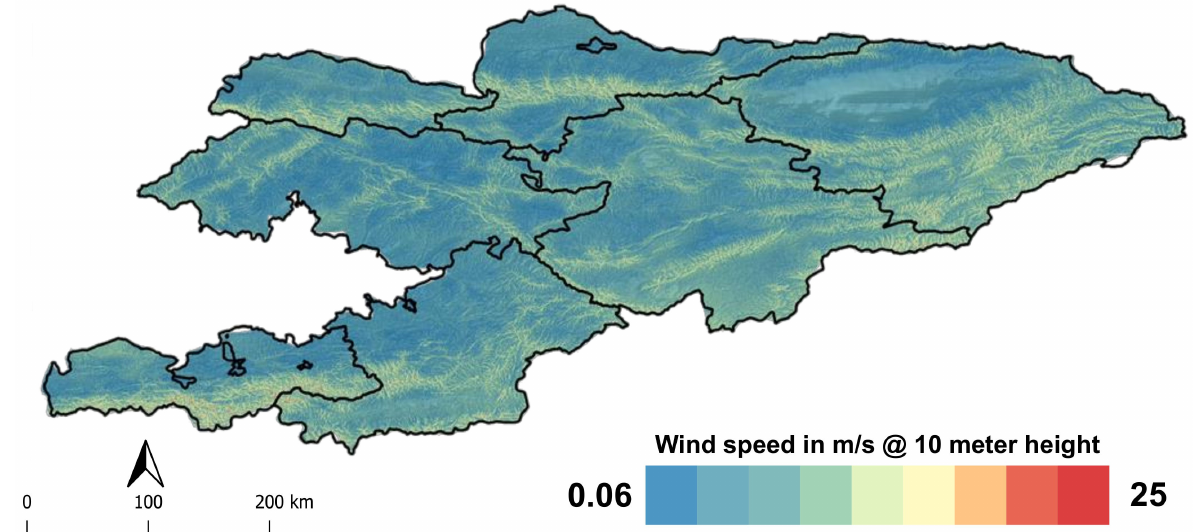
Figure 3. Wind speed atlas of Kyrgyzstan at 10 m in height (own illustration based on